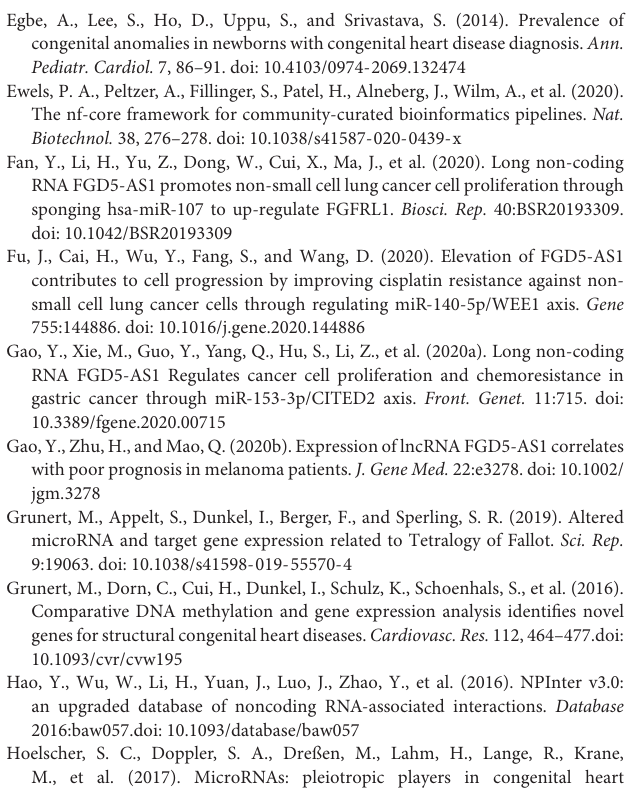
Supplementary Table 7 | Full lists of enriched known motifs of transcription factors within the differential accessible region